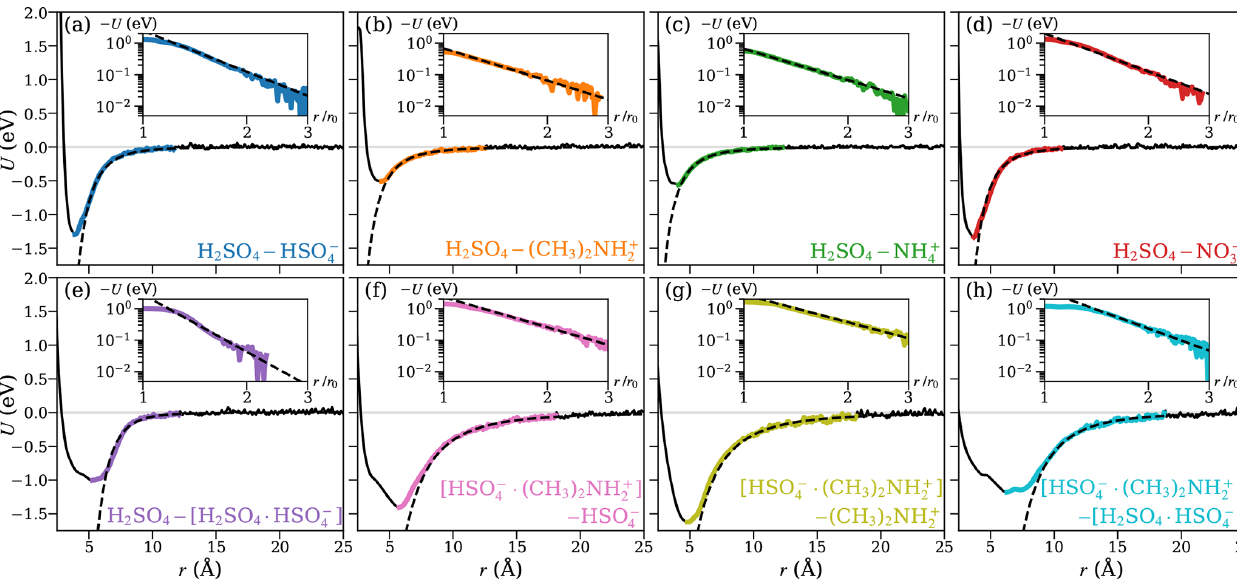
Figure 3. The potential of mean force (PMF) along the center-of-mass distance between the collision partners for the systems of H 2 SO 4 and (a) HSO − , (b) (CH 3 ) 2 NH + , (c) NH + , (d) NO − (top row), and (e) H 2 SO 4 and the [H 2 SO 4 · HSO − 4 2 4 3 dimer, and (f) HSO − , and (g) (CH 3 ) 2 NH + and (h) the [H 2 SO 4 · HSO − ] dimer (bottom row). The solid black lines show the PMF curves 4 2 4 obtained from well-tempered metadynamics simulations. The range over which the attractive interaction is fitted using Eq. (1) is highlighted in color and shown on a logarithmic scale in the insets. The fits are shown as dashed black